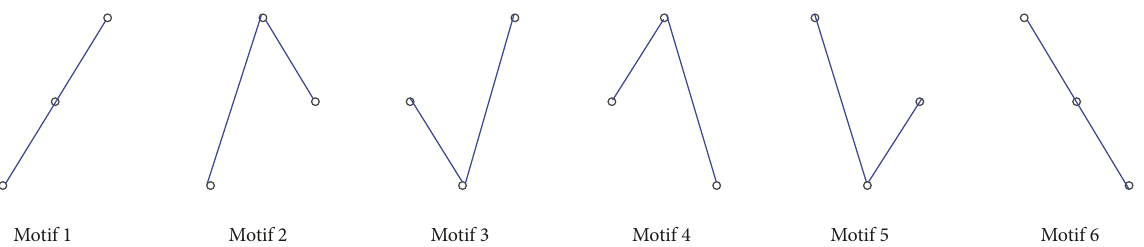
Figure 1: Six motifs for the embedding dimension 𝑚 = 3 , including “slopes,” “peaks,” and